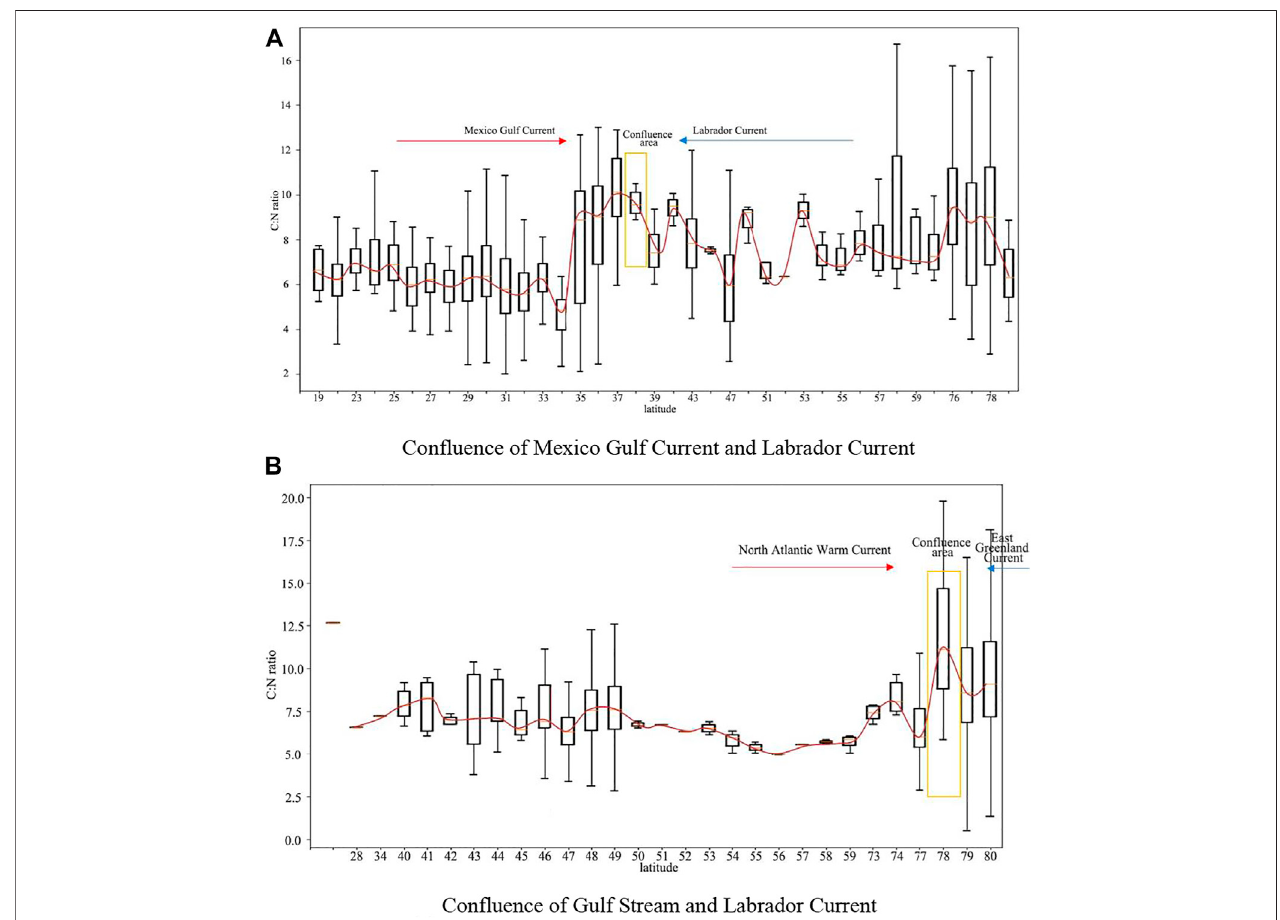
FIGURE 7 | Con fl uence of warm and cold currents. (A) Con fl uence of the Mexico Gulf Current and Labrador Current. (B) Con fl uence of the Gulf Stream and Labrador Current.